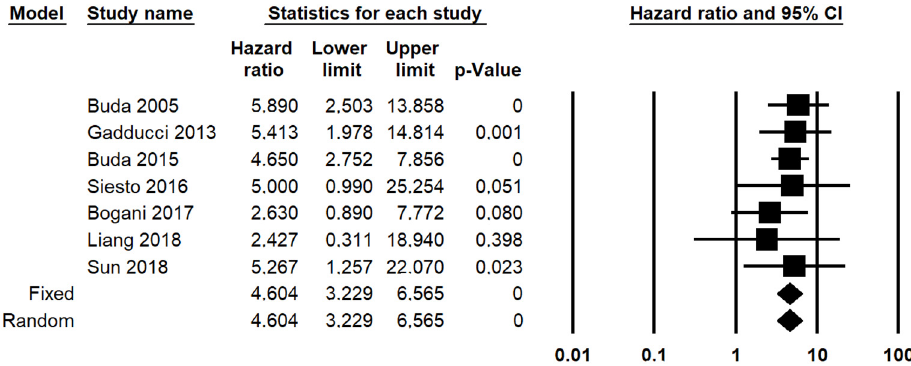
Figure 3. Forest plot reporting hazard ratio (HR) for overall survival in patients with cervical cancer treated, underwent neoadjuvant therapy, obtained by dichotomizing pathological response as “residual tumor with >3 mm stromal invasion” vs. “residual tumor with <3 mm stromal invasion”.